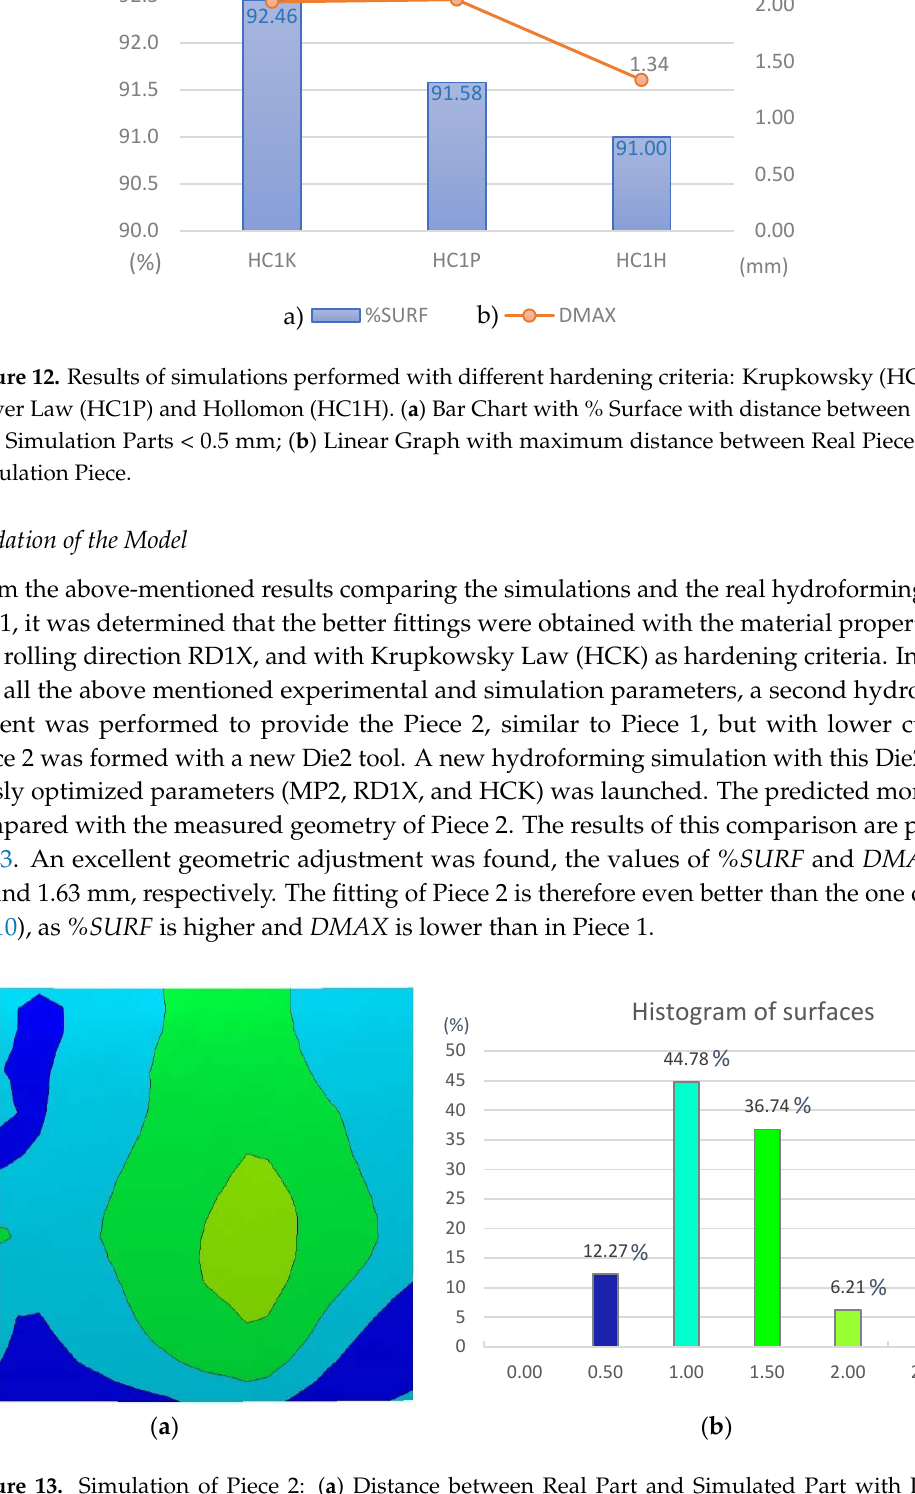
Figure 11. Hardening curves of the material UNS A92024-T3 aluminum alloy according to Krupkowsky, Power Law, and Hollomon criteria.